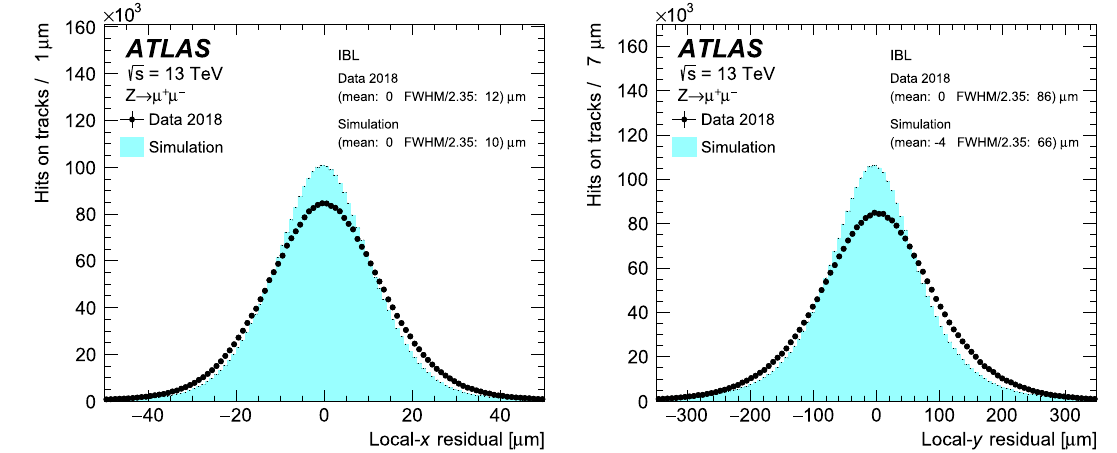
Fig. 4 The IBL local- x (left) and local- y (right) residual distributions for the Z → μ + μ − data sample compared with simulated data. The distributions are integrated over all hits on tracks in barrel modules